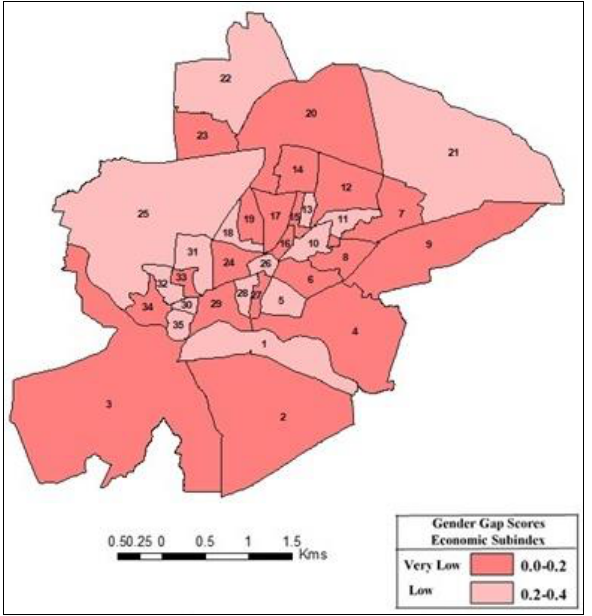
Fig. 5. Scores on the Economic Participation subindex, of the Gender Gap Index, Sehore M.C.,